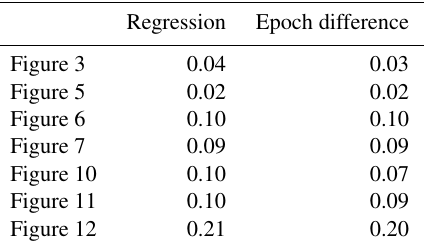
Table 3. The rms error values calculated over the entire globe (Eq. 3) for each of the figures. All units are in mmday − 1 for differ- ences (Figs. 3, 6, 7, 10, 11, and 12) or mmday − 1 K − 1 for patterns (Fig. 5).